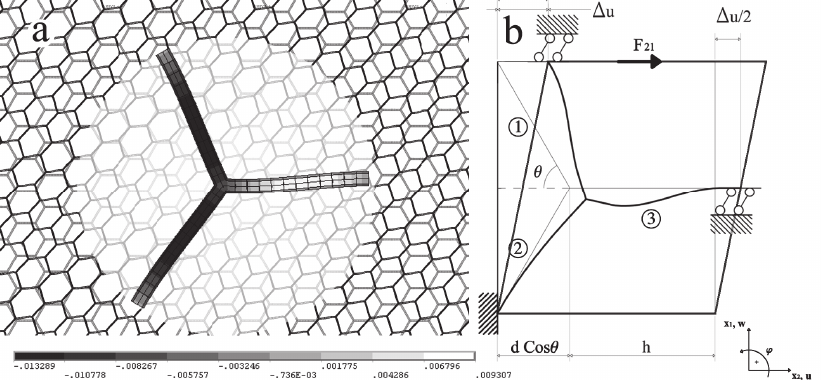
Figure 11: Hexagrid - shear test; a) deformed configuration; b) definition of the